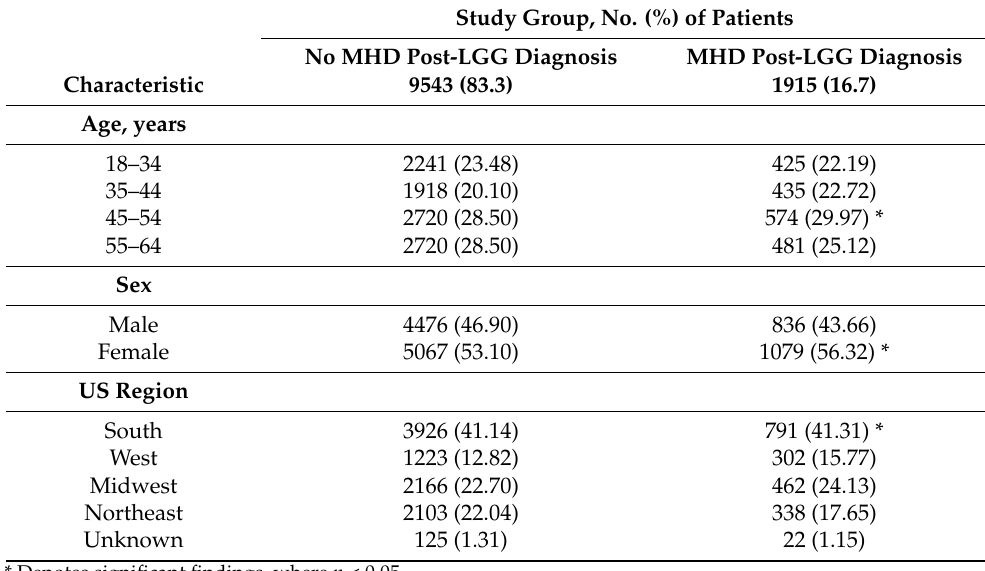
Table 2. Sociodemographic and clinical comparison of low-grade glioma patients with and without mental health disorder onset within 12 months post-LGG diagnosis.